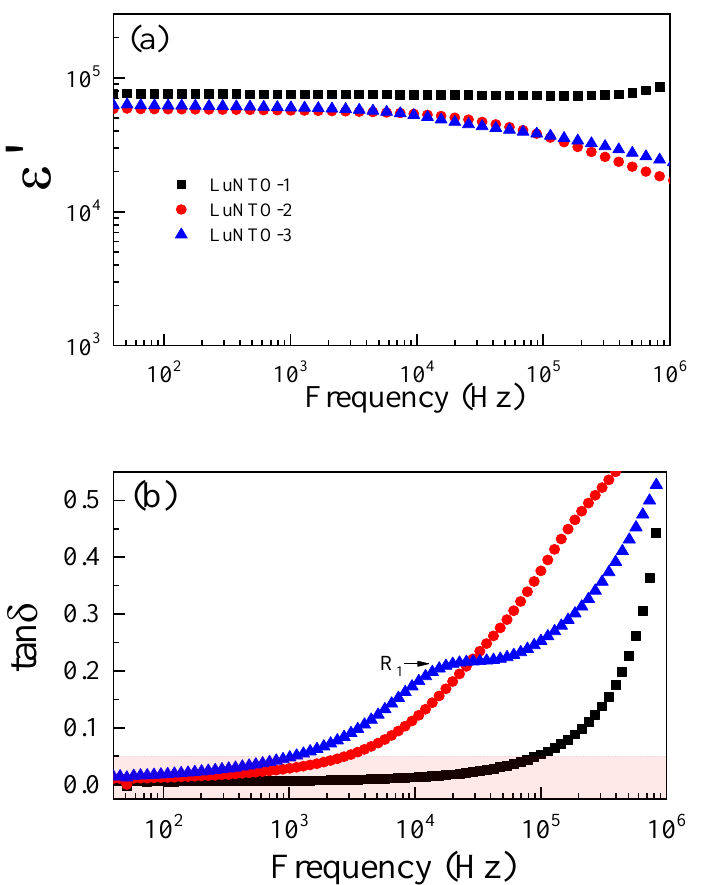
Figure 7. ( a ) Dielectric permittivity ( ε’ ) and ( b ) loss tangent (tan δ ) at 30 °C for LuNTO ceramics in the frequency range of 40–10 6 Hz.